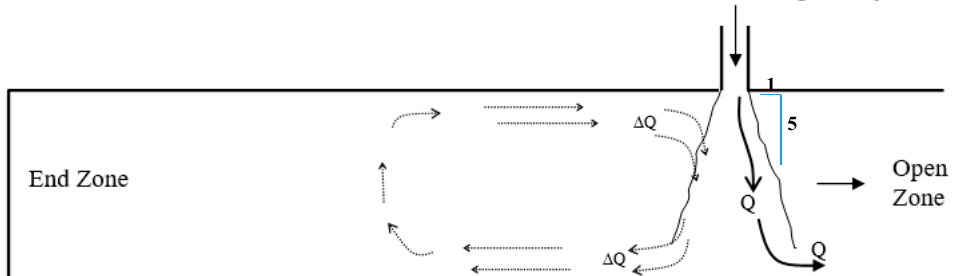
Figure 4. Sketch of flow circulation within the closed end (multiple circulating eddies driven by the purging jet might form).